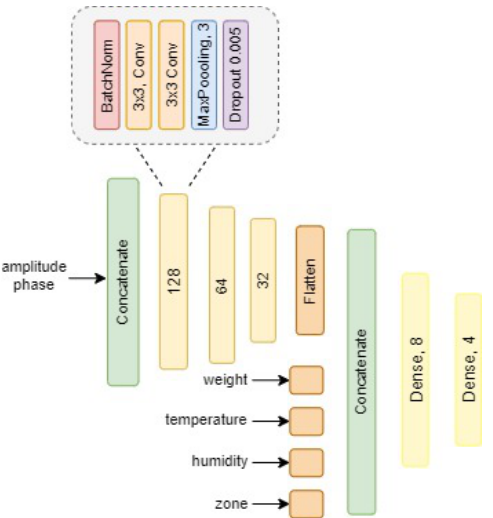
Figure 3. Visualisation of the DL architecture. The information extraction of the amplitude and phase results based on four convolutional modules with descending filter size towards the